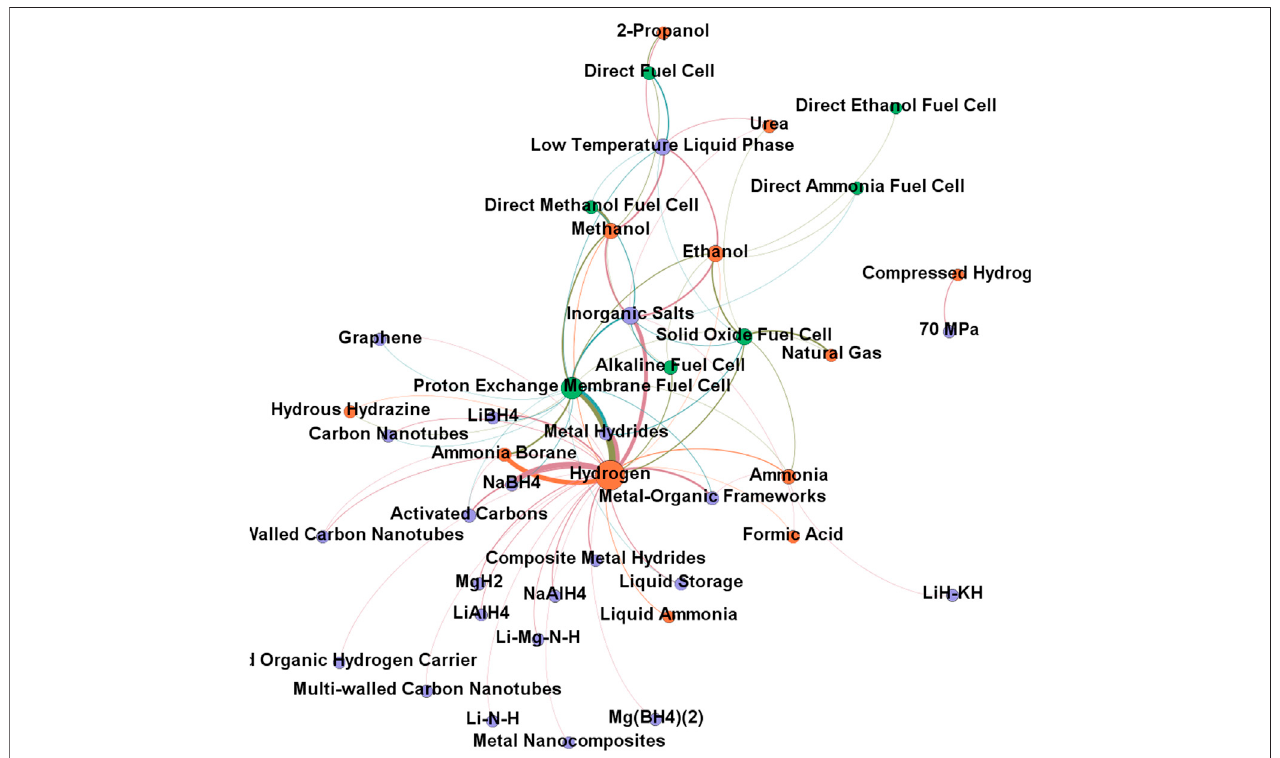
FIGURE9| SchematicdiagramoftheOHSSheterogeneousknowledgenetworkduring2012 – 2015.Note:Thenumberofnodesis42;Theweightofedgesis276; The number of edges is 71.